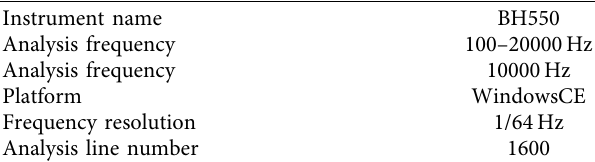
Table 6: Signal acquisition